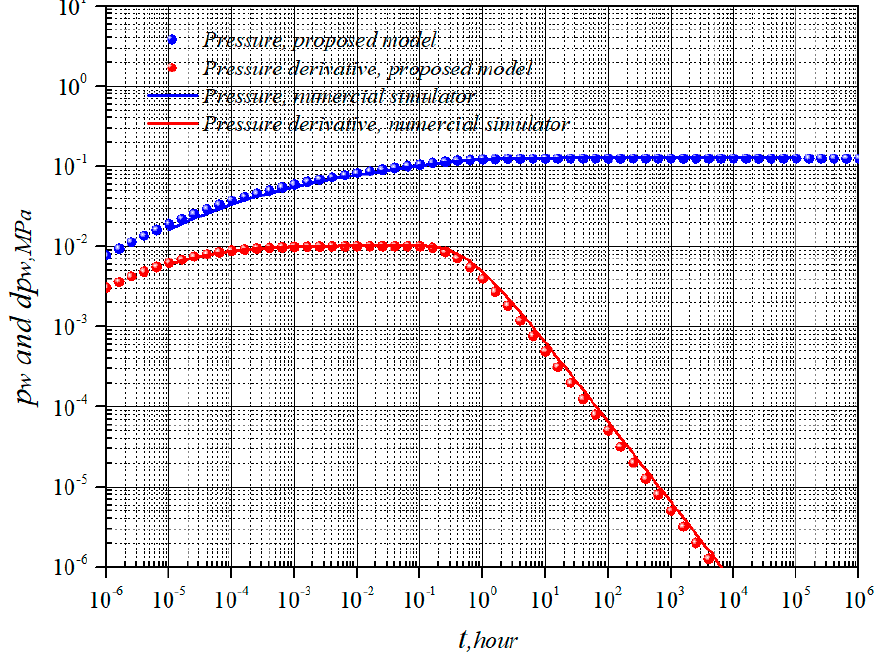
Figure 3. Comparison of the proposed model and numerical simulator for homogeneous model case 2.